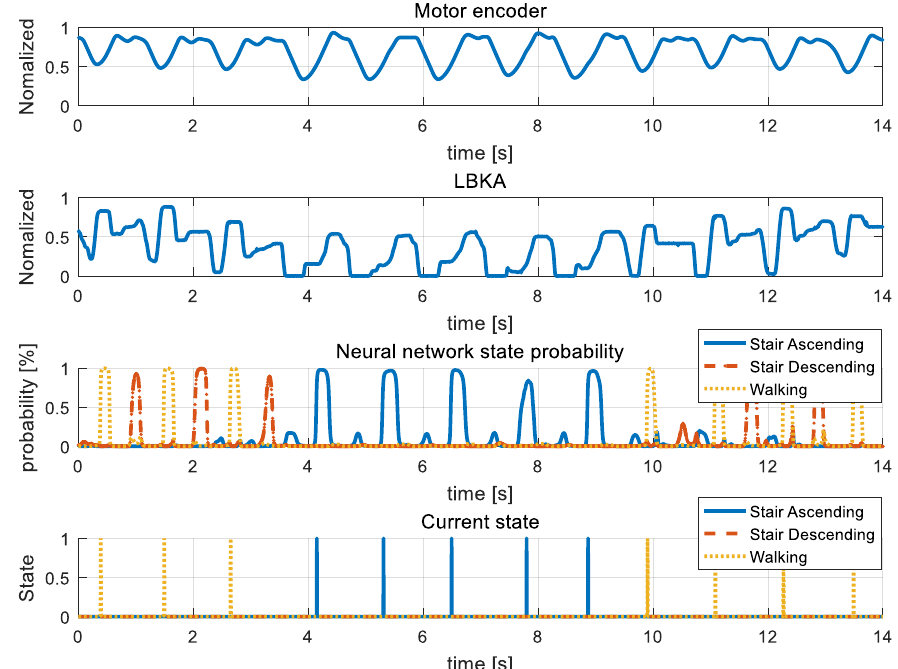
Figure 16. Mixed stair descending experiment. In the graph, sensor data, neural network, and current data results in walking – stair descending – walking mixed state are plotted.